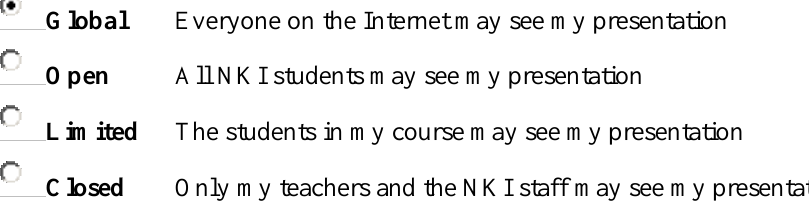
Figure 3. Choose learning partner preference and visibility level: An element from the students‟ user interface.